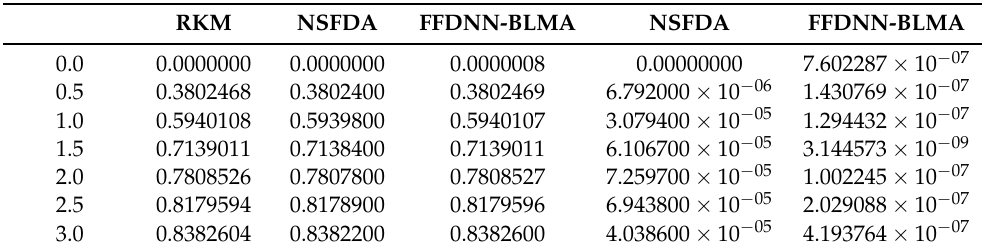
Table 4. Evaluation of the error values of the approximate solutions estimated by the designed method for the fluid speed with isoflux boundary conditions.